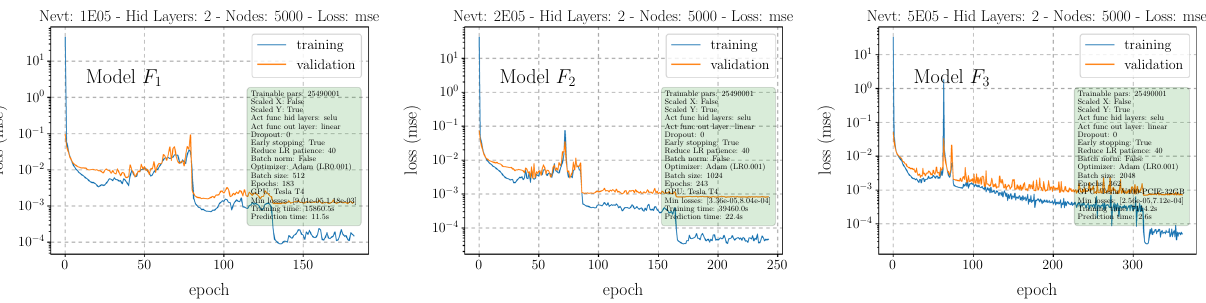
Fig. 12 Training and validation loss (MSE) vs number of training epochs for models F 1 − F 3 . The jumps correspond to points of reduction of the Adam optimiser learning rate